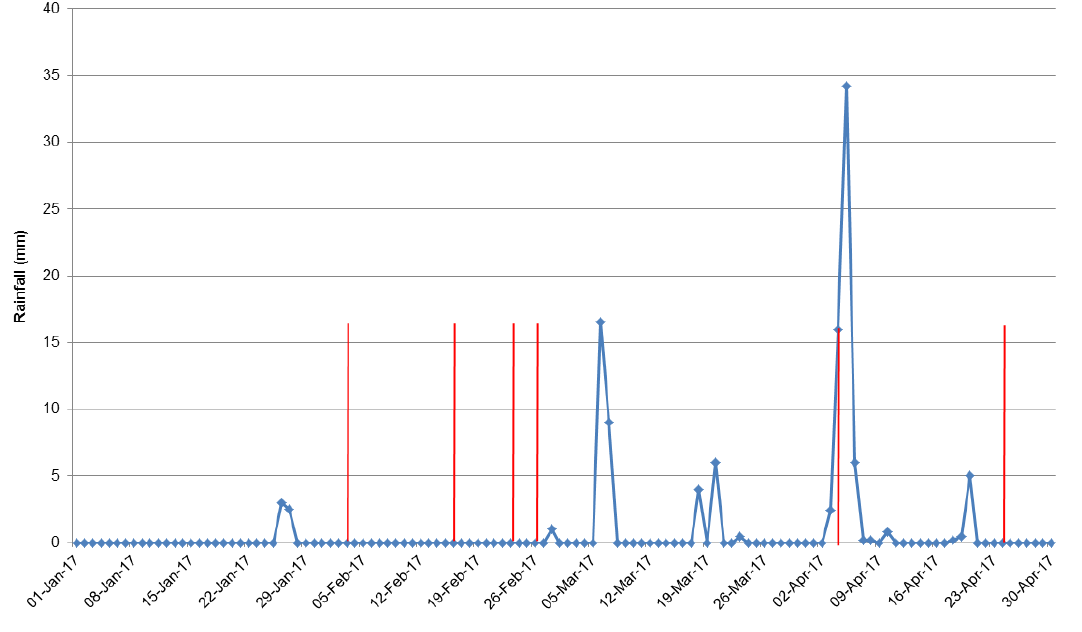
Figure 2. Rainfall (in mm) measured every day at 6 am, over Maddur village (Berambadi). Vertical red lines indicate the dates of Sentinel-2 images